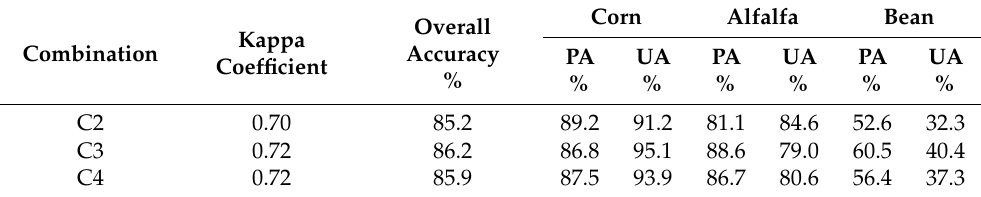
Table 12. Results of the classification on 5 June in the 2020 agricultural cycle.